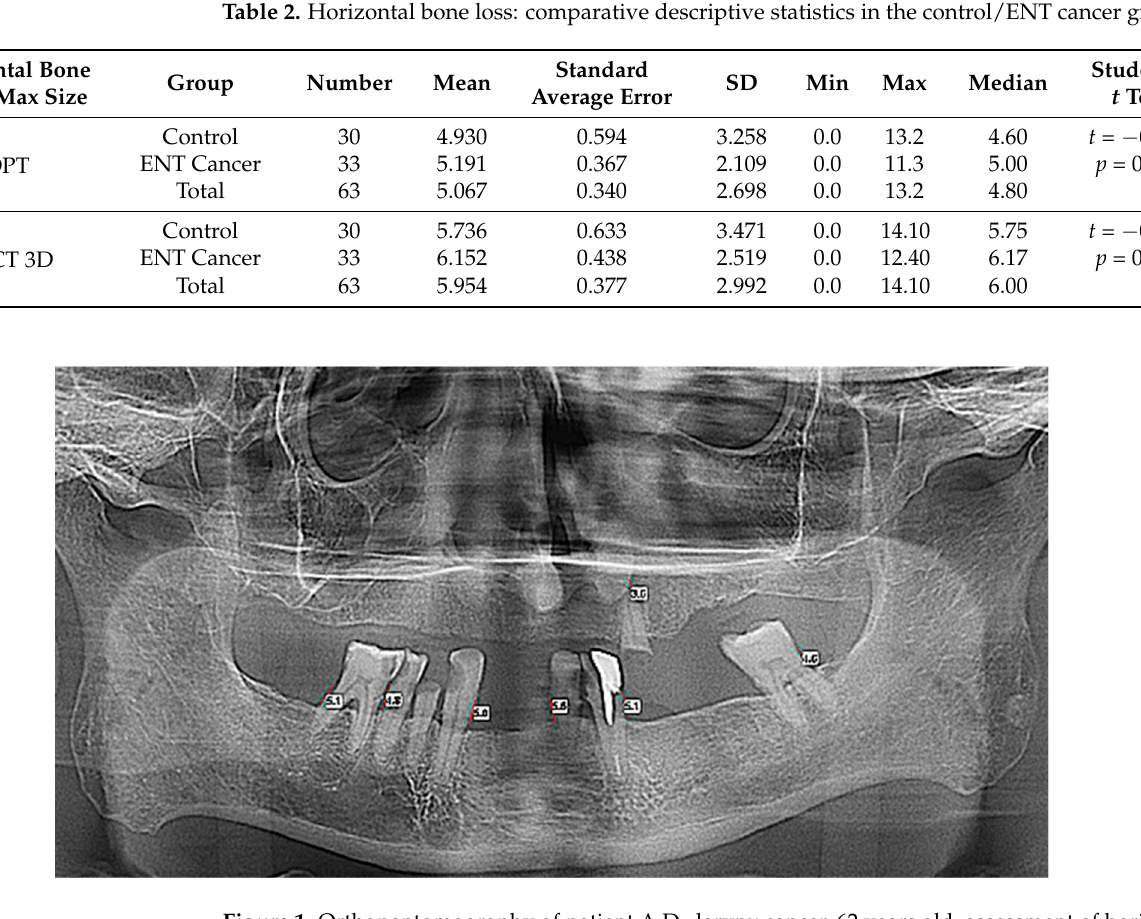
Table 2. Horizontal bone loss: comparative descriptive statistics in the control/ENT cancer group.